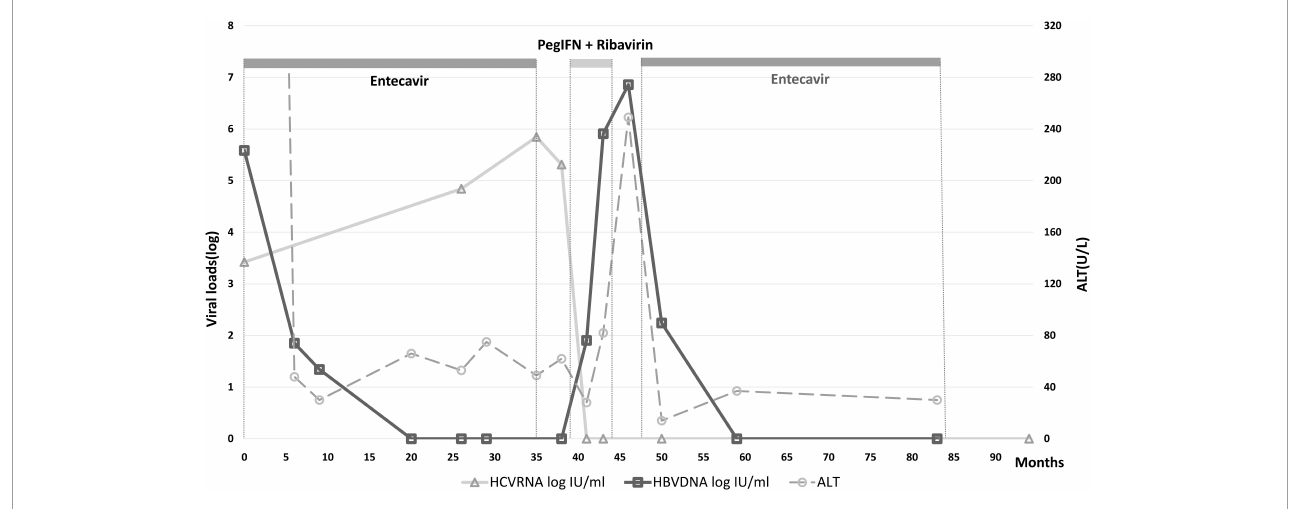
FIGURE1 Longitudinal changes of HBV DNA, HCV RNA, and ALT levels of the HBV and HCV-coinfected patient. PegINT, pegylated